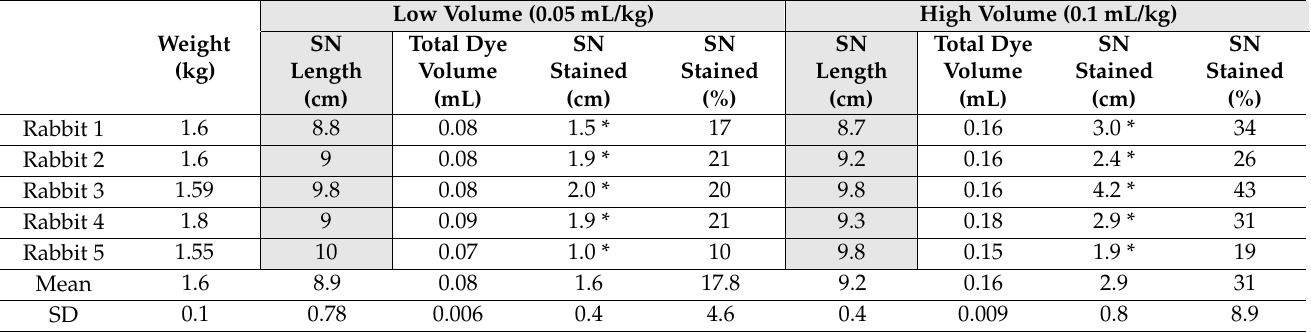
Table 1. Evaluation of the extent of nerve staining obtained by performing ultrasound-guided saphenous nerve (SN) blocks using a dye solution [permanent yellow tissue dye in lidocaine 2% (1:50)] in five rabbit cadavers (10 hind-limbs) with either low (0.05 mL/kg) or high (0.1 mL/kg) volume. Values (mean ± standard deviation) are reported for saphenous nerve total length, the length of the staining obtained, the total volume of dye solution injected for each hind-limb, and the percentage of the total length of saphenous nerves stained. SD: standard deviation; * The difference between the length of the SN nerves staining obtained using low or high volumes of dye solution was statistically significant ( p = 0.0476; Fisher’s Exact test). The background colour is necessary to distinguisci between the tho nerves ot the two different legs of the same